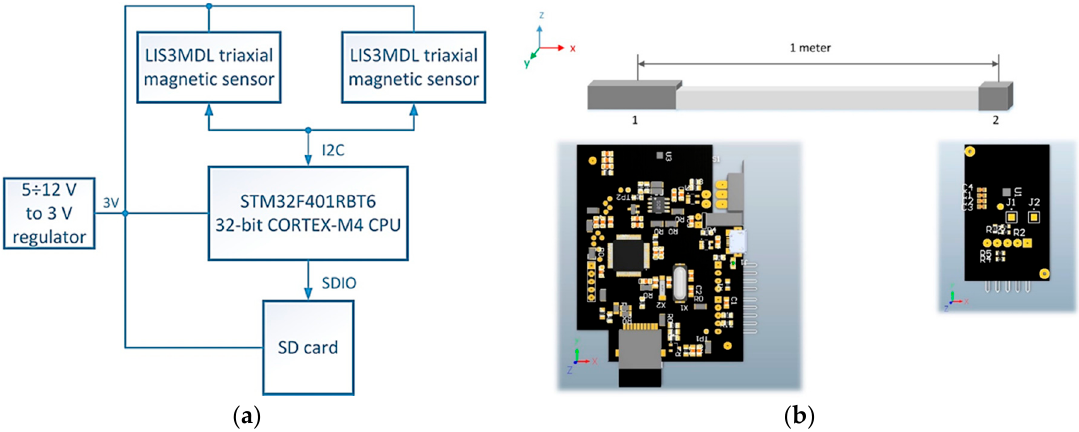
Figure 1. ( a ) The block scheme of the measuring system. ( b ) Developed PCBs for data acquisition, supplied from battery, connected by a wire and covered in plastic